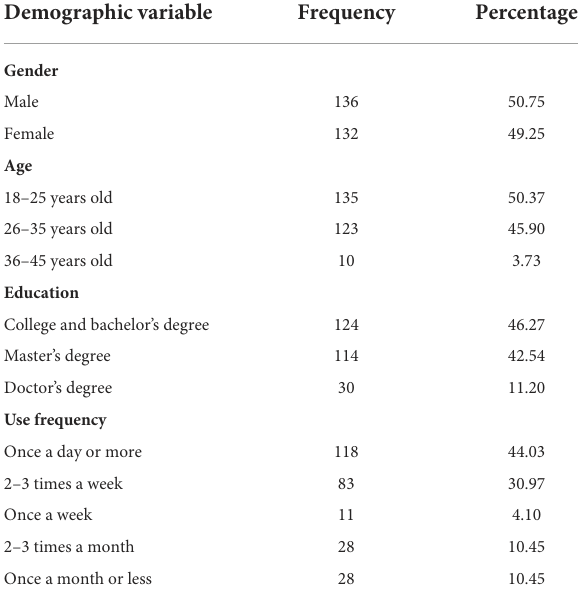
TABLE 2 Demographic of respondents ( N =